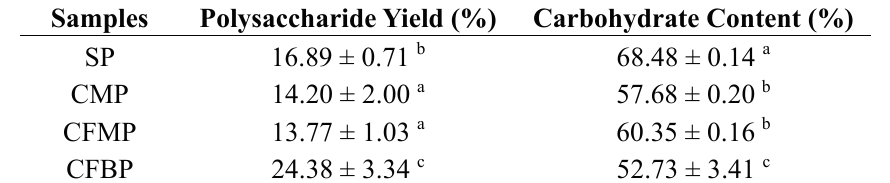
Table 1. The polysaccharide yields and carbohydrate contents of SP, CMP, CFMP and CFBP.